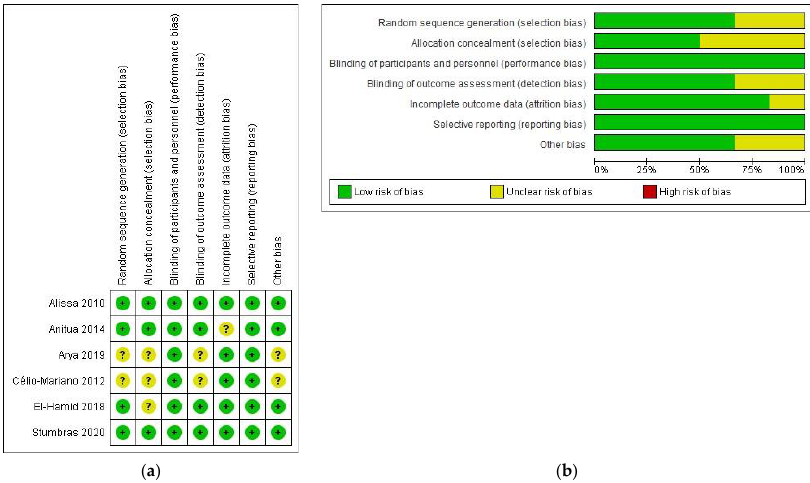
Figure 2. Study selection flow diagram. PRISMA flow diagram of the screening and selection pro- cess. Quality assessment of the included RCTs. ( a ) Risk of bias summary: review authors’ judgments about each risk of bias item for each included study: (+), low risk of bias; (?): unclear risk of bias. ( b ) Risk of bias graph: review authors’ judgments about each risk of bias item presented as percentage